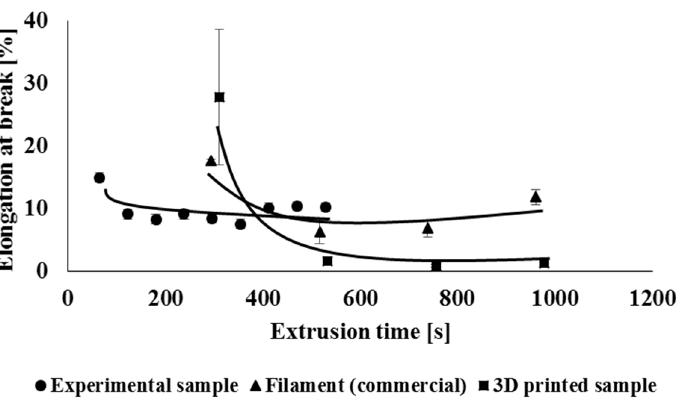
Figure 17. Dependence of the elongation at break on the total processing time of the polymeric material.